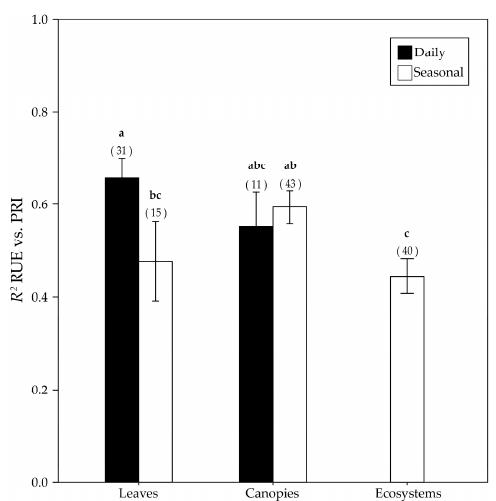
Figure 9. Comparison of the strength of the relationships between PRI and RUE across temporal and spatial scales. Each bar represents the average coefficient of determination for each source of temporal variation (daily or seasonal) and spatial scales (leaf, canopy and ecosystem). Different letters indicate significant differences ( p < 0.05). Error bars represent the standard errors, and the numbers of reported correlations are shown in brackets.